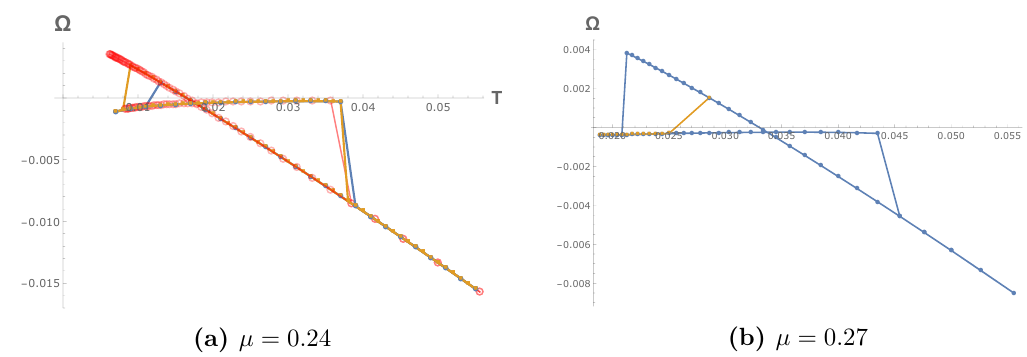
Figure 2. Plot of grand potential (cid:10) with varying temperature T for di(cid:11)erent values (cid:22) . Phase transition from chaotic phase to integrable phase occurs at di(cid:11)erent temperatures. (a) The blue curve is for temperature step (cid:1) T = 0 : 002. The orange curve is for (cid:1) T = 0 : 001. The red curve is for inverse temperature steps (cid:1) (cid:12) = 2. The transition from integrable phase to chaotic phase occurs at the same temperature 1 =(cid:12) (cid:24) 1 = 26. (b) The blue curve is for (cid:1) (cid:12) = 2. The orange curve shows the transition from chaotic to integrable phase when the system is suddenly cooled down from (cid:12) = 35 to (cid:12) =